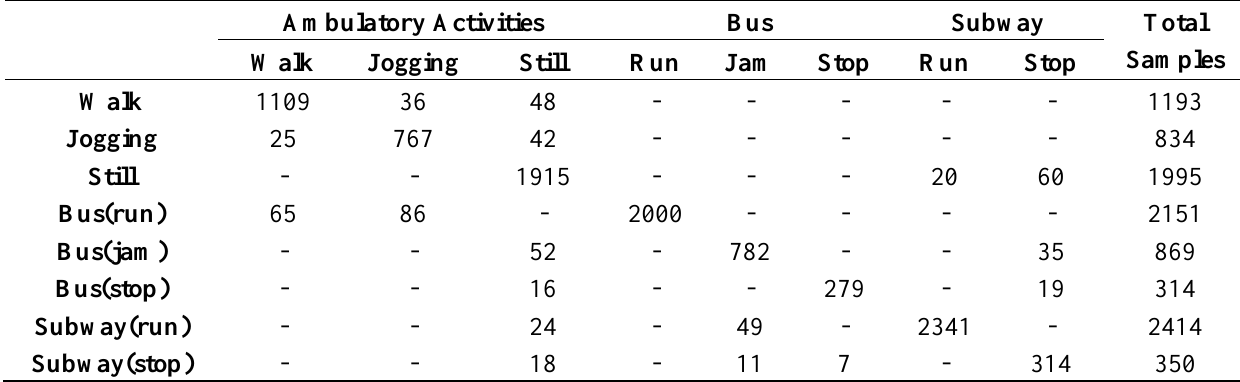
Table 5. Evaluation of the integrated system with realistic and real-time